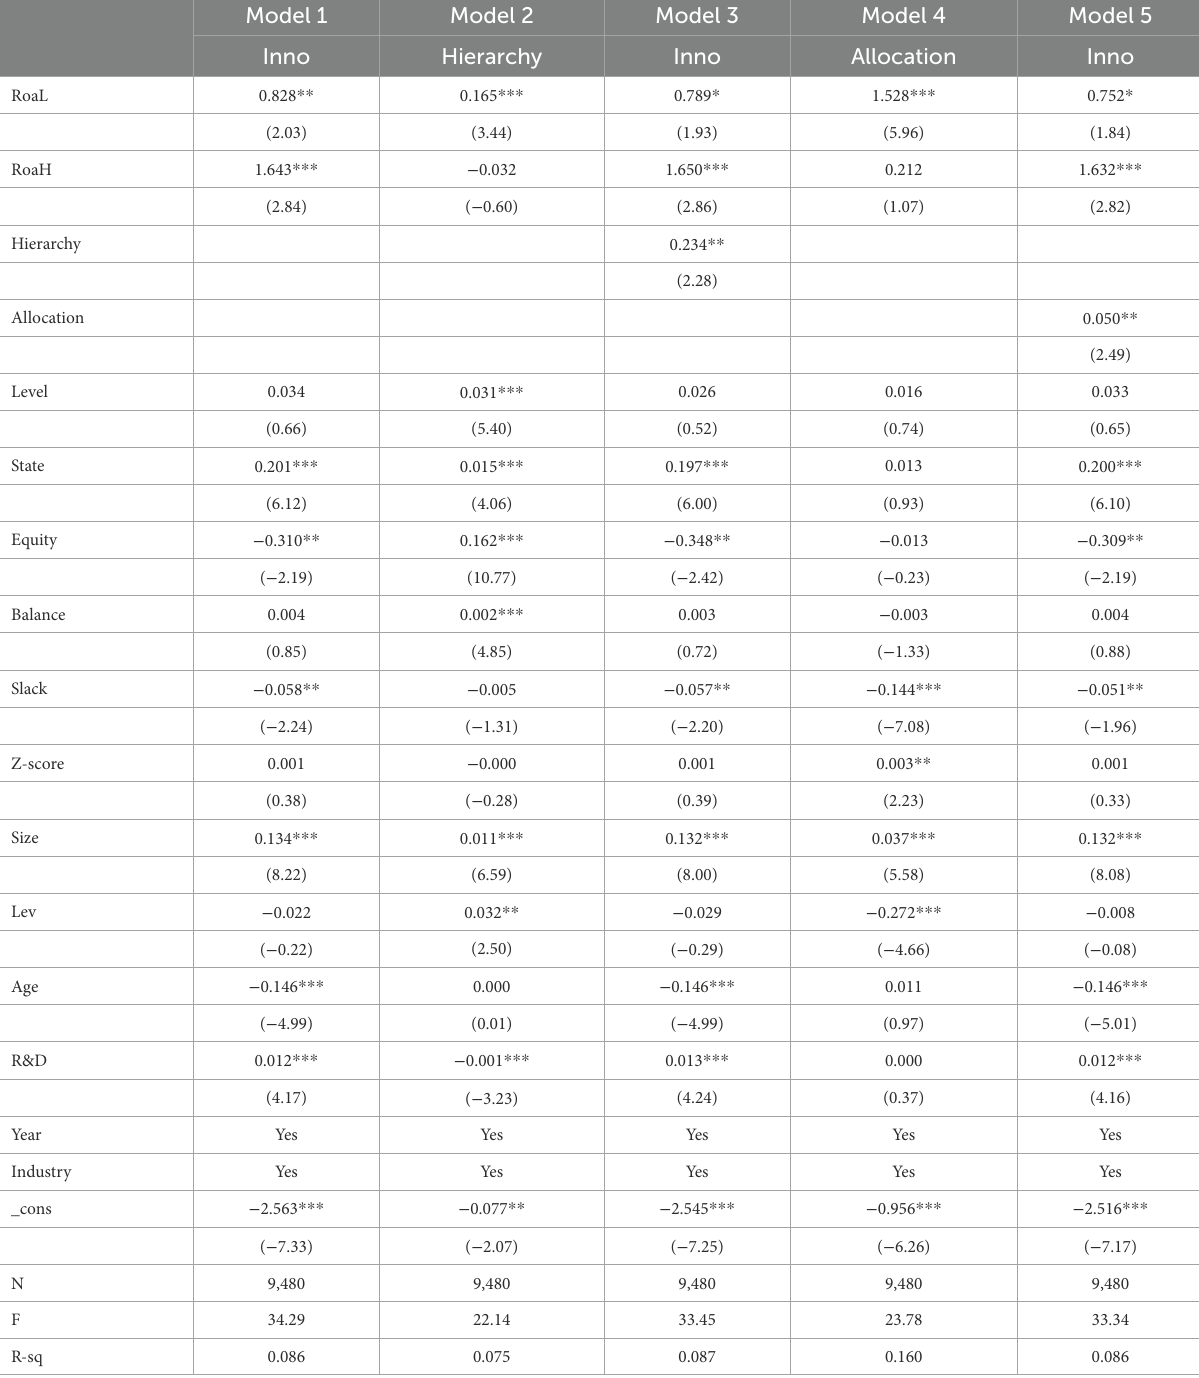
TABLE 5 Results of the tests for the effect of peer performance